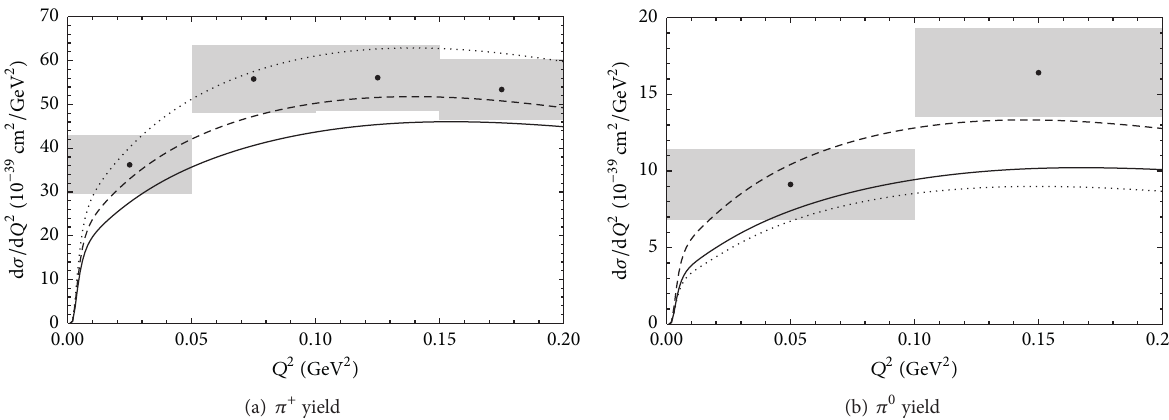
Figure 5: Charged and neutral pion production for the MiniBooNE spectrum and comparison with experimental data. The dotted line is the cross-section without nuclear corrections, the dashed line with constant absorption 𝐴 = 0.9 , and the solid line with 𝐴(𝑄 2 ) interpolated from (14) to (16). The curves with 𝐴 = 0.9 give a better